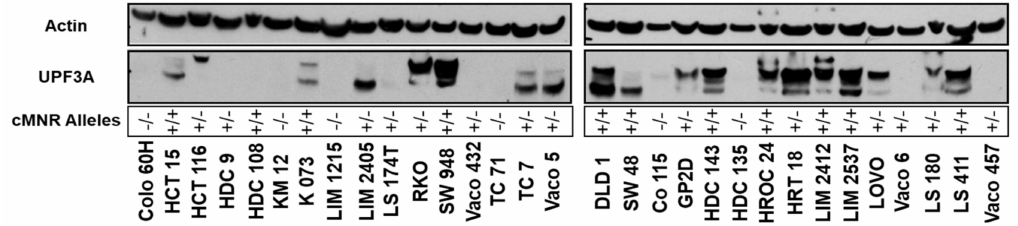
Figure 1. Western Blot analysis of UPF3A protein expression in colorectal cancer cell lines. SW948 cells (MSS) served as UPF3A expression control while ß-actin was used as loading control. The status of wildtype ( + ) and mutated ( − ) cMNR alleles for each cell line is